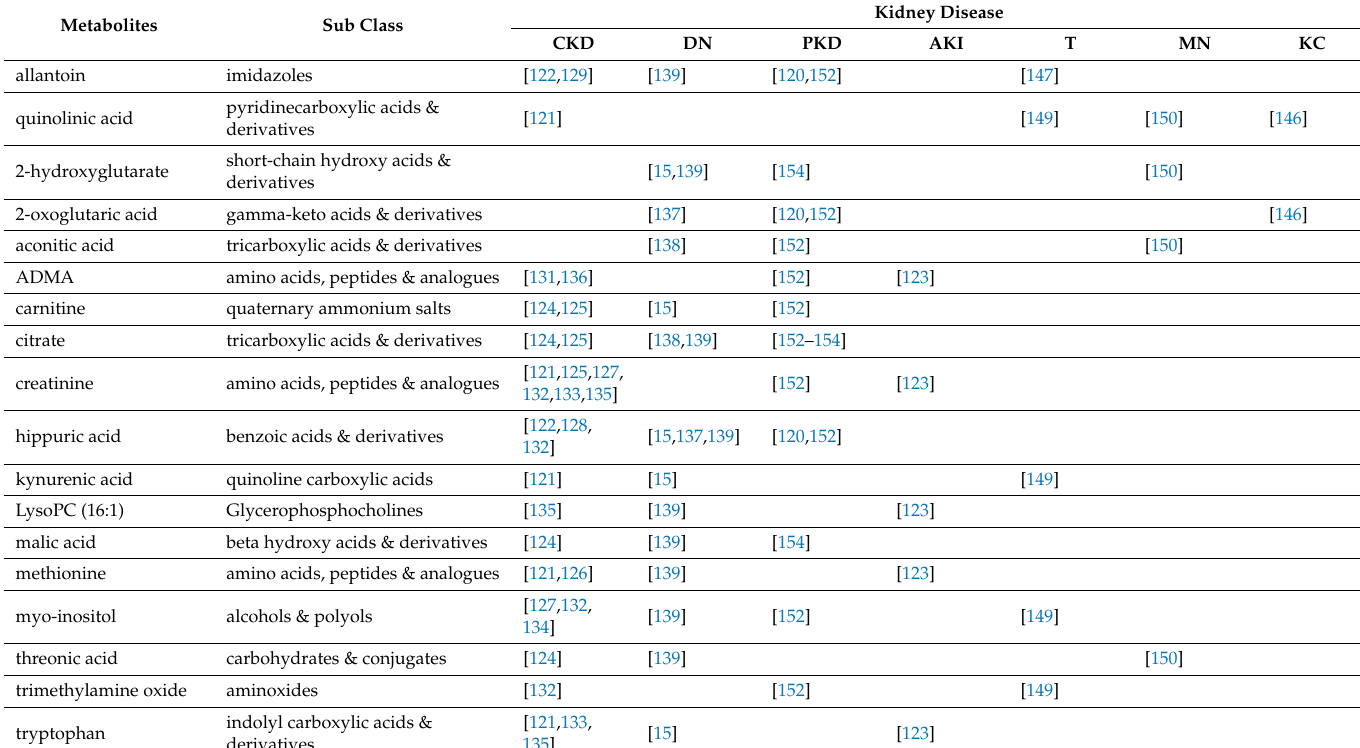
Table 3. Metabolites which have been reported as important for two or more kidney diseases from the list of studies in Table 2. Darker colour indicates metabolite reported in greater number of kidney diseases. CKD: Chronic kidney disease; DN: Diabetic nephropathy; PKD: Polycystic kidney disease, AKI: Acute kidney injury; T: Kidney transplantation; MN: Membranous nephropathy; KC: Kidney cancer. *sub class not available, # class provided, ¥ super class provided, § not